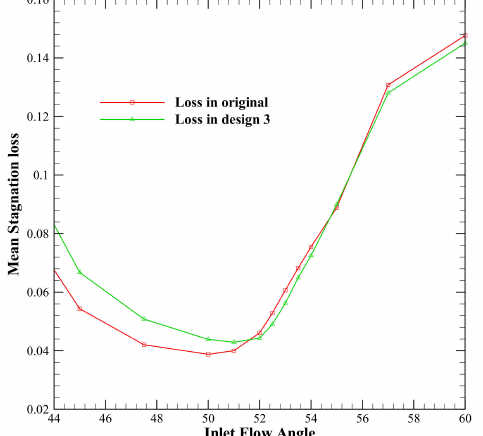
Figure 31. Variation of loss coefficient and deviation flow angle versus inlet flow angle for the current and third designed blade cascades.